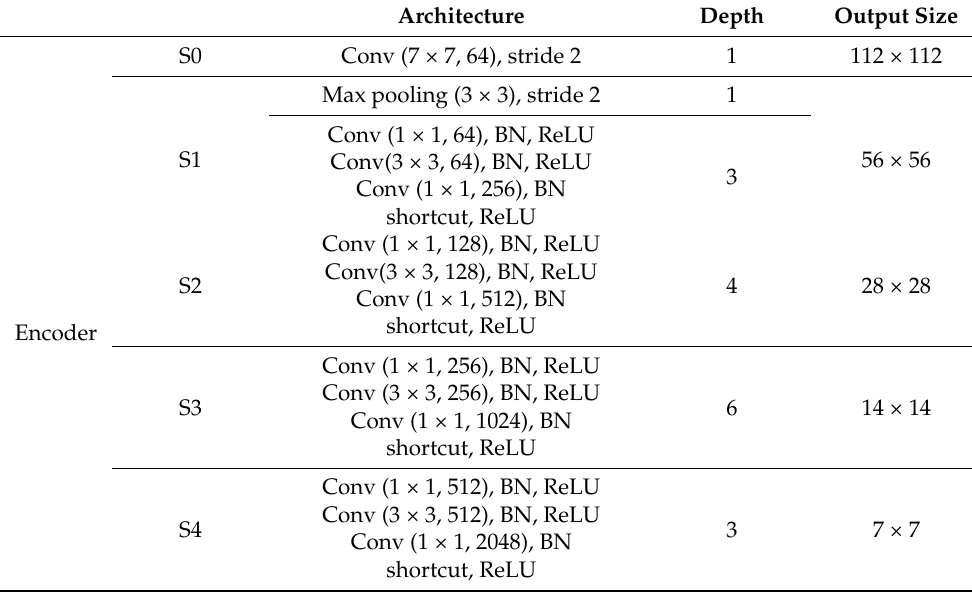
Table A1. We show the architecture of the image encoder ImageNet pretrained ResNet-50 [15] in our method. The used ResNet-50 [15] has five stages, which are represented in the table as S0, 1, 2, 3, and 4,